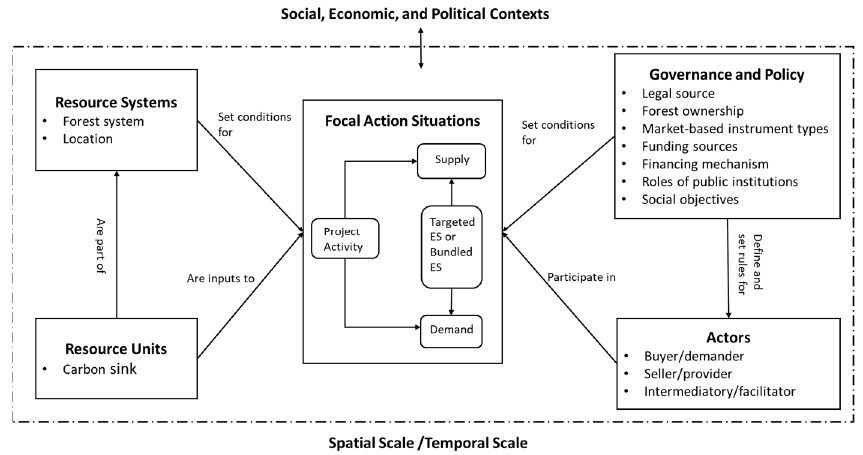
Figure 6. Conceptual model for governance of market-based instruments for forest carbon (adapted from McGinnis & Ostrom [65]).